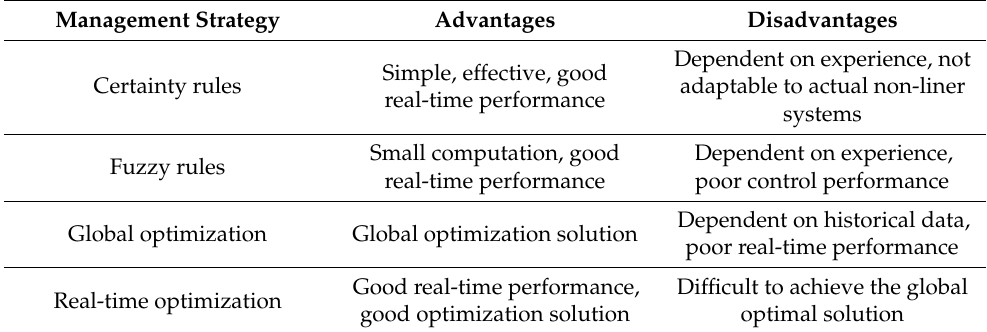
Table 1. Advantages and disadvantages of energy management strategy of hybrid ships. Management